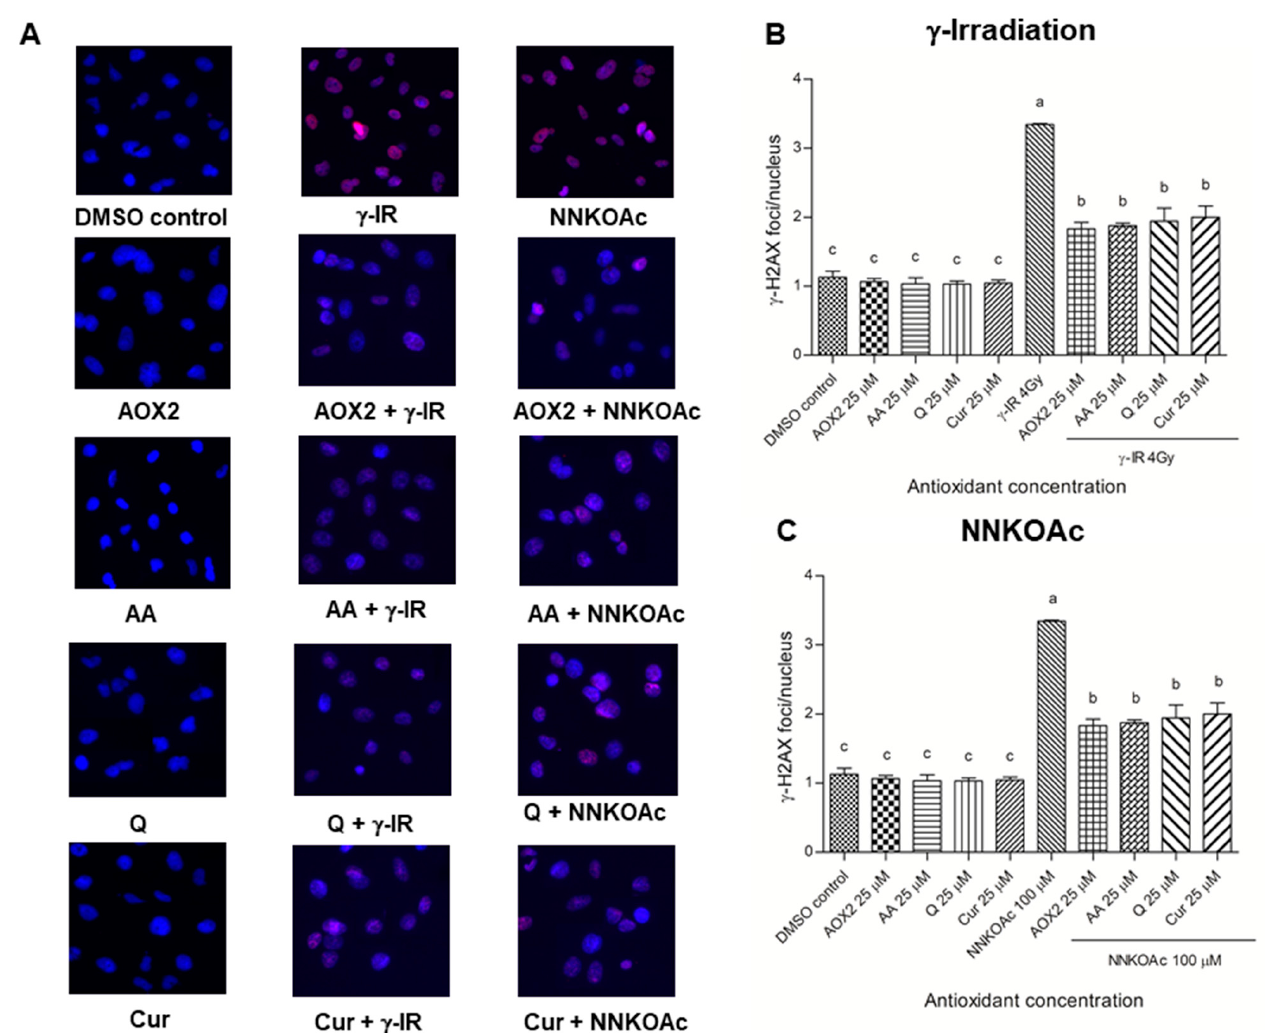
Figure 5. BEAS-2B cells were exposed to γ -irradiation, carcinogen, or in combination with pre-incubation with antioxidants followed by immunofluorescence staining with γ -H2AX antibody and photographed by epifluorescence microscopy at a magnification of 100× ( A ). The nuclei were stained blue, whereas the γ -H2AX foci (S 139) appeared red. Phosphorylated-H2AX level was reduced by pre-exposure to tested antioxidants in γ -irradiation ( B ) or carcinogen ( C ) induced BEAS-2B cells. Quantification of focus/nucleus ratio was calculated for each sample from at least 30 cells. Experimental values are presented as mean ± SD of three independent experiments in triplicate. One-way analysis of variance was performed with Tukey’s pairwise comparison. Means that share the same letter are not significantly different at p ≤ 0.05. Abbreviations: AOX2, dietary antioxidant formulation-2; Cur, curcumin; DMSO, dimethyl sulfoxide; γ -IR, γ -irradiation.